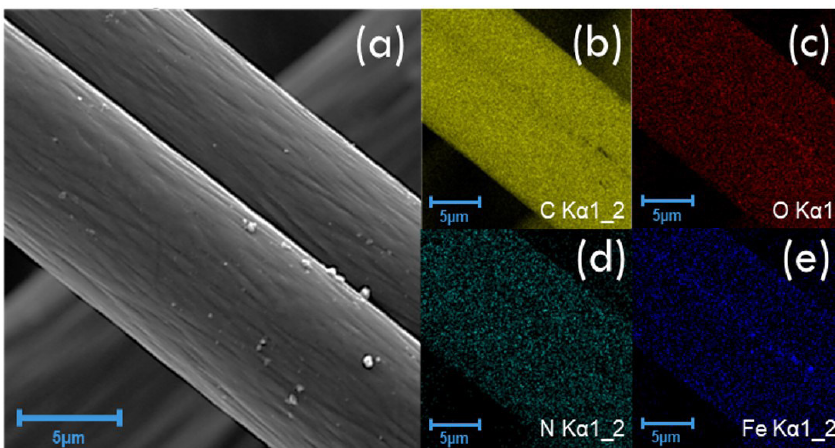
Figure 2. SEM image of (a) ACC140_Fe and its respective elemental mapping of (b) carbon (C); (c) oxygen (O); (d) nitrogen (N), and (e) Iron (Fe).